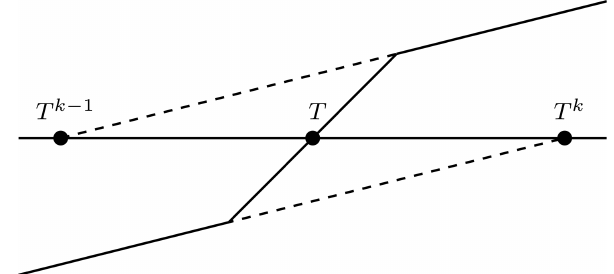
Figure 5. A scheme of the problem which illustrates how the Newton–Raphson method cannot converge towards T (Dall’Amico, 2010). In this case, the Newton–Raphson method fails to converge to T since it cycles between T k and T k + 1